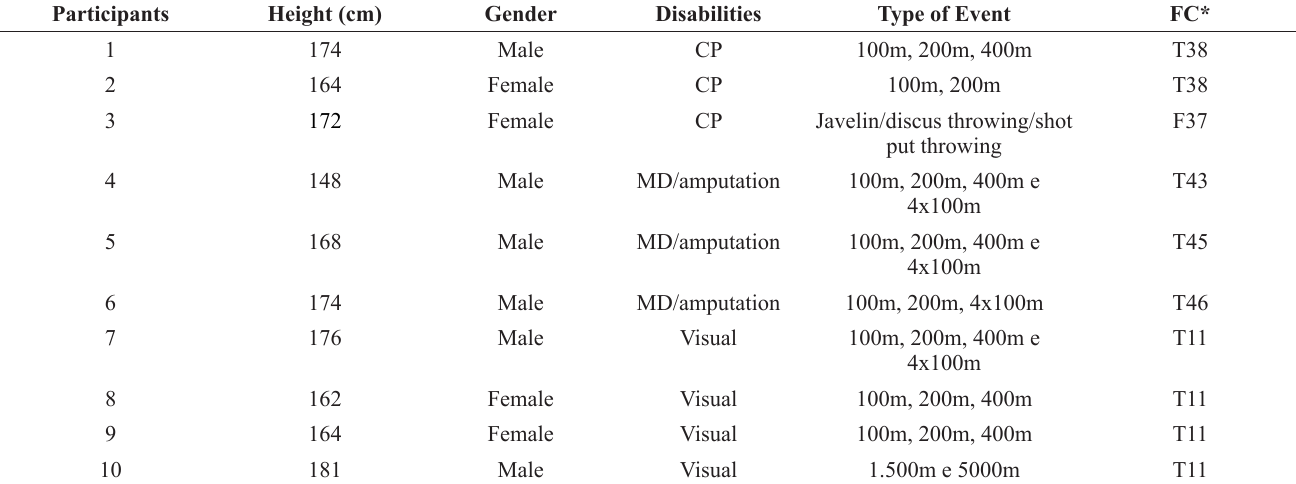
Table 1. Distribution of the athletes by gender, height, disabilities, specialty and sporting classification.